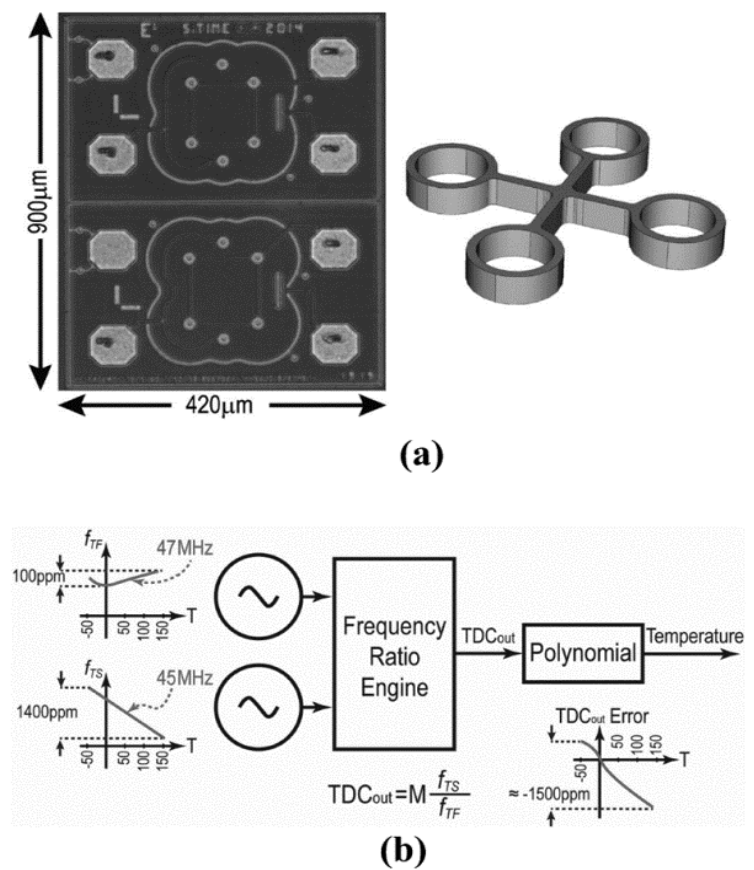
Figure 24. ( a ) 3-D view of MEMS resonators and the MEMS dies photo; ( b ) Architecture of a temperature sensor operating based on measuring the ratio of the frequencies. Reproduced with permission from [120]. Copyright © 2017, IEEE.